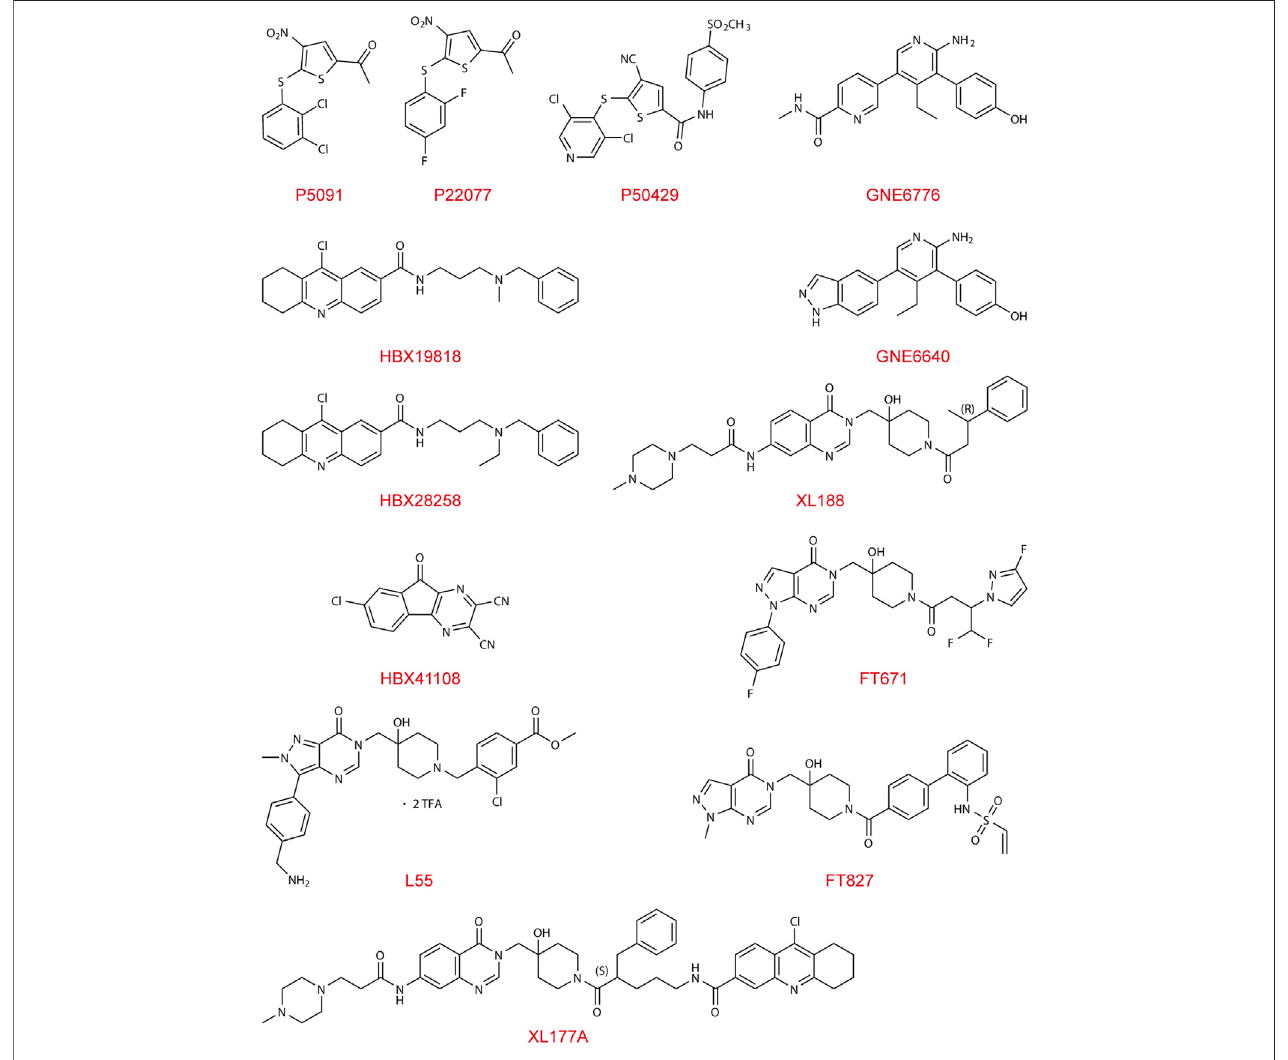
FIGURE 2 | Chemical structures of USP7 inhibitors.